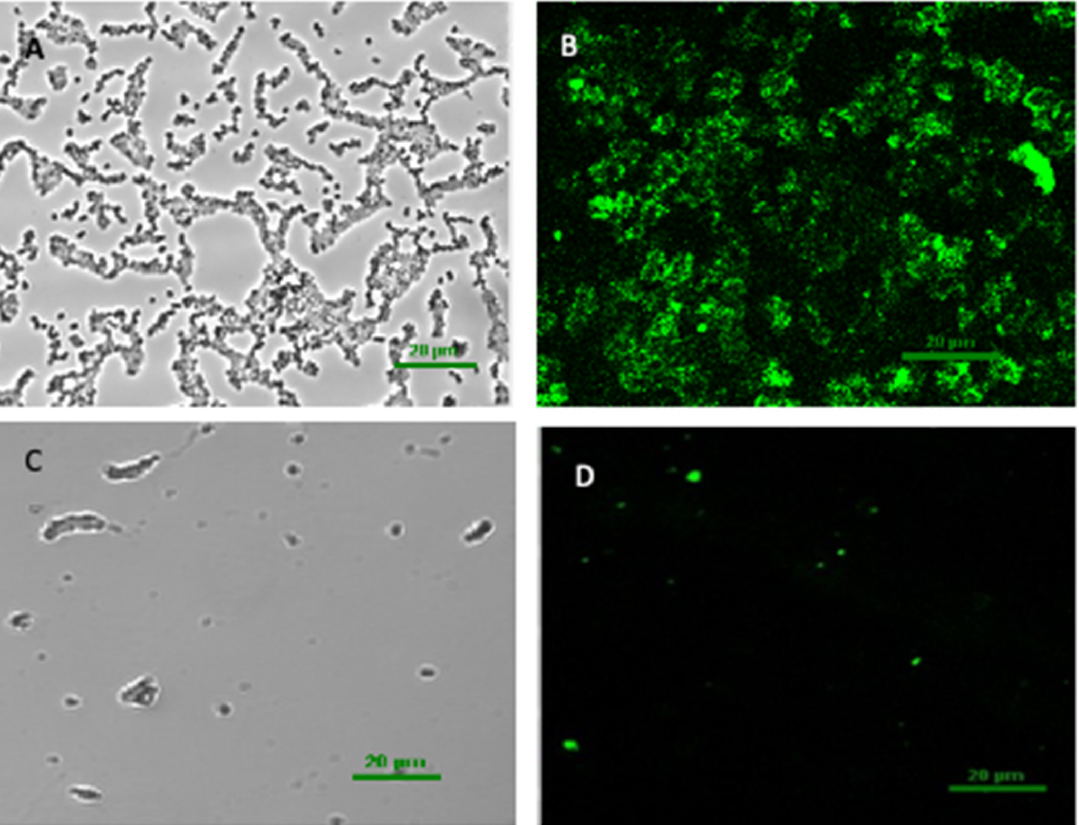
Figure 3. The representative confocal laser scanning microscope (CLSM) images of biofilm structure of V. parahaemolyticus incubated in 24-well microplates for 24 h. Control: ( A , C ) (addition of FITC); combined enzyme treatment: ( B , D ) (addition of FITC). The green color in ( B , D ) demonstrate the distribution of exopolysaccharide (EPS).